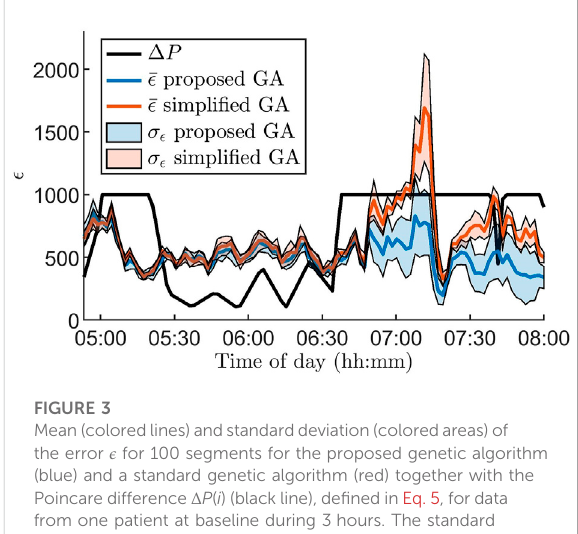
FIGURE 3 Mean(coloredlines)andstandarddeviation(coloredareas)of the error ϵ for 100 segments for the proposed genetic algorithm (blue) and a standard genetic algorithm (red) together with the Poincare difference Δ P ( i ) (black line), de fi ned in Eq. 5, for data from one patient at baseline during 3 hours. The standard deviation and mean are based on ten runs of the algorithms. Note that Δ P ( i ) is scaled with 1 5 for